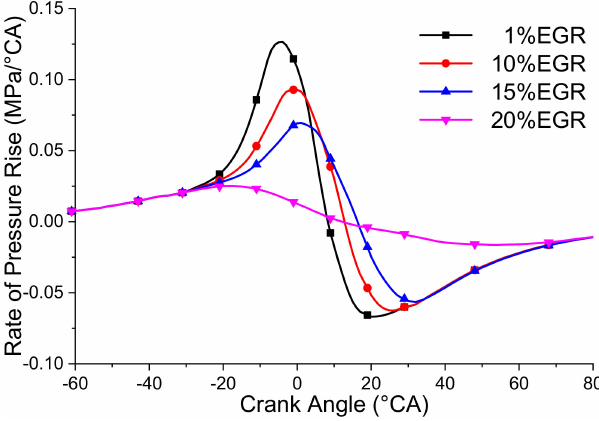
Figure 9. Influence of the EGR ratio on pressure increase rate.